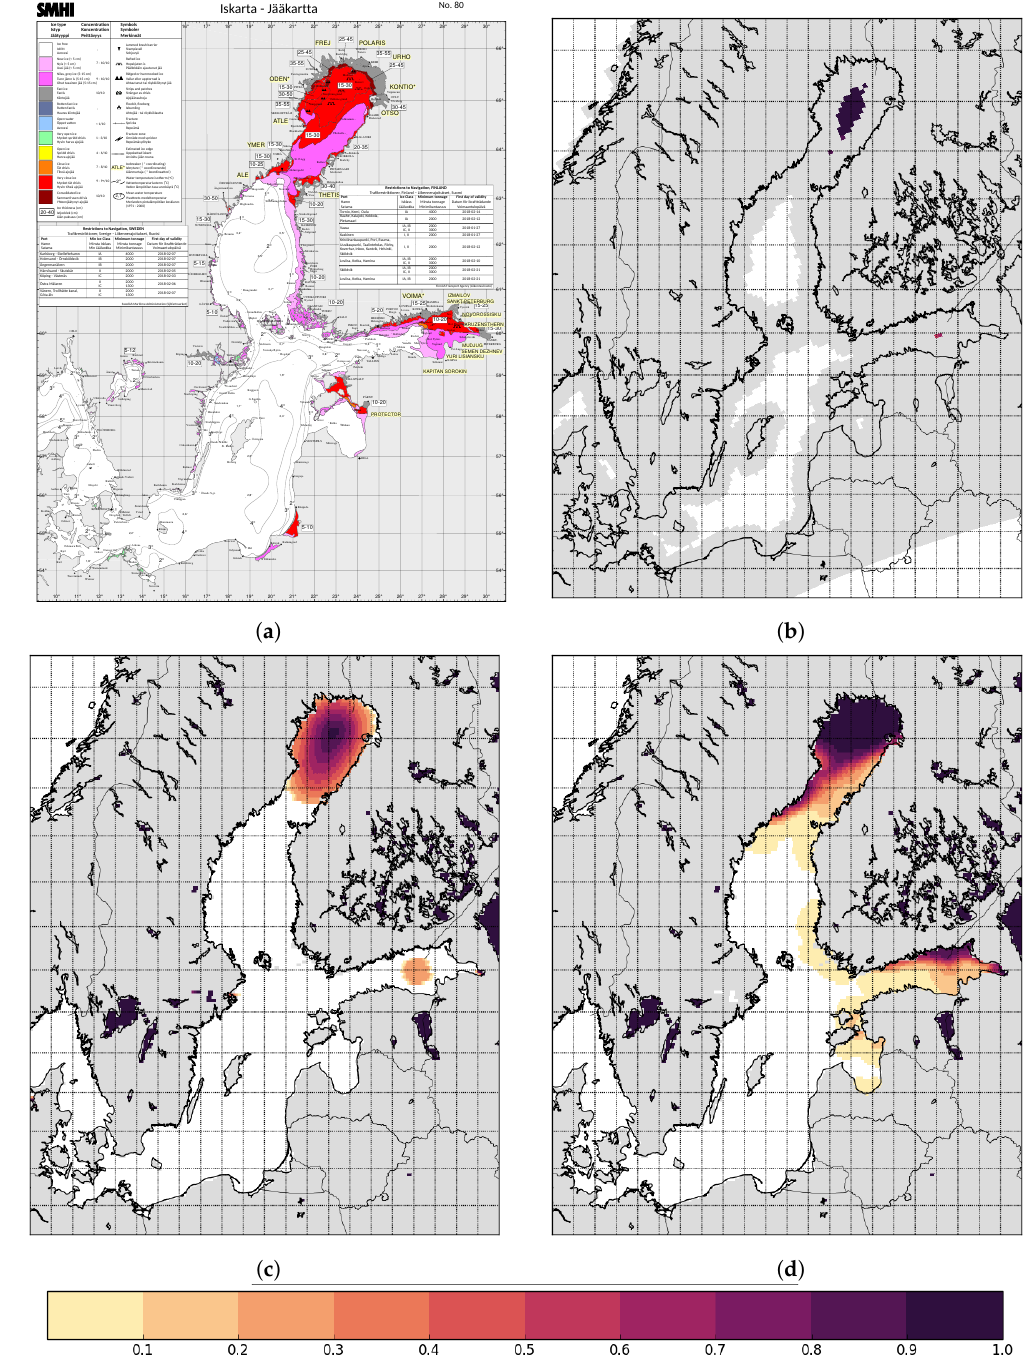
Figure 13. ( a ) Manually produced Finnish–Swedish ice chart of the Baltic Sea. © [44] Reproduced with permission. ( b ) OSI SAF 401-b product. Note missing data (grey) around coastlines due to coastal contamination in satellite retrievals of sea ice concentration. ( c ) Uncoupled analysis. Note the Gaussian nature of the ice field centred on the available OSI SAF L3 observations. ( d ) WCDA. Note the much more realistic structure and the good agreement with the manual ice chart. A manual ice chart ( a ) and sea ice concentration values in the Baltic sea on 17 February 2018 from OSI SAF L3 observations ( b ), uncoupled analysis ( c ) and WCDA ( d